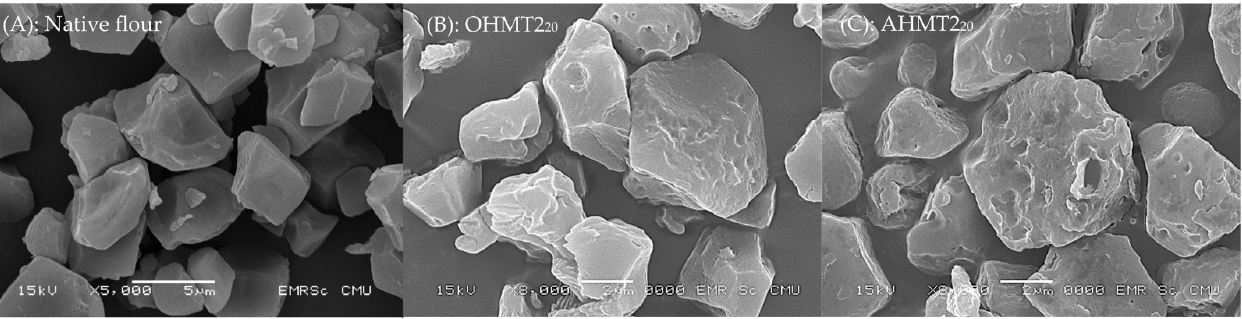
Figure 4. Scanning electron microscope images of purple rice fl our exposed to di ff erent